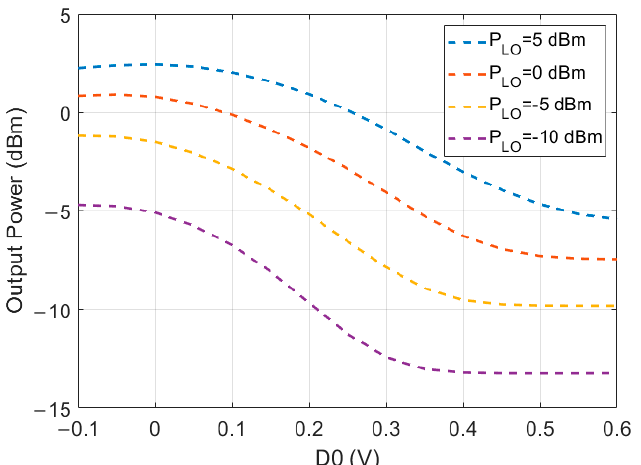
Figure 4. Simulated output power for different data input voltages of the MSB (D0), with different input power (LO). The LSB (D1) is set to 0 V, and the LO frequency is 130 GHz.